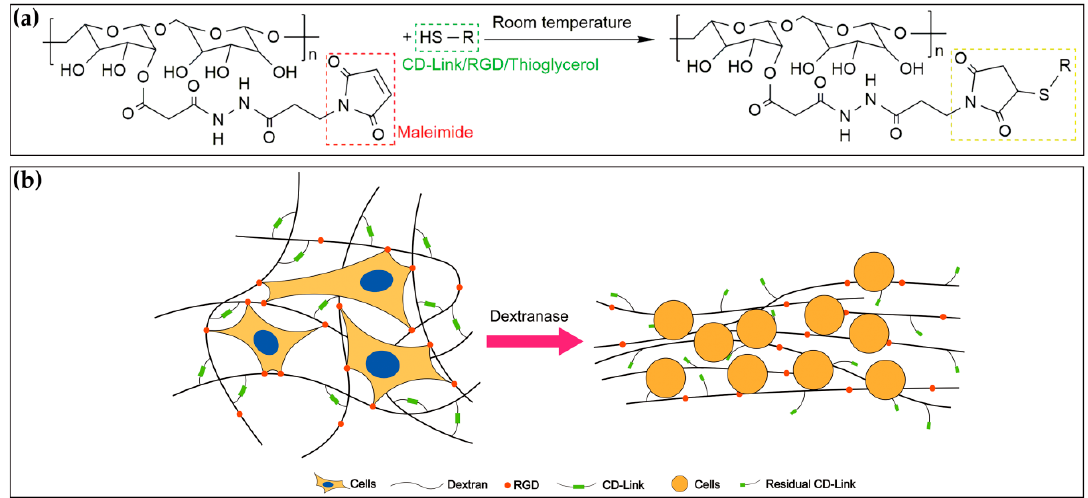
Figure 1. Fabrication and degradation of 3D homogenous mal-dextran hydrogels. ( a ) Maleimide– thiol reaction formula: maleimide groups were on dextran and thiol groups (-SH) were on CD-Link (thiol-containing crosslinker), RGD peptides, and thioglycerol; ( b ) Degradation of the formed dextran hydrogel.